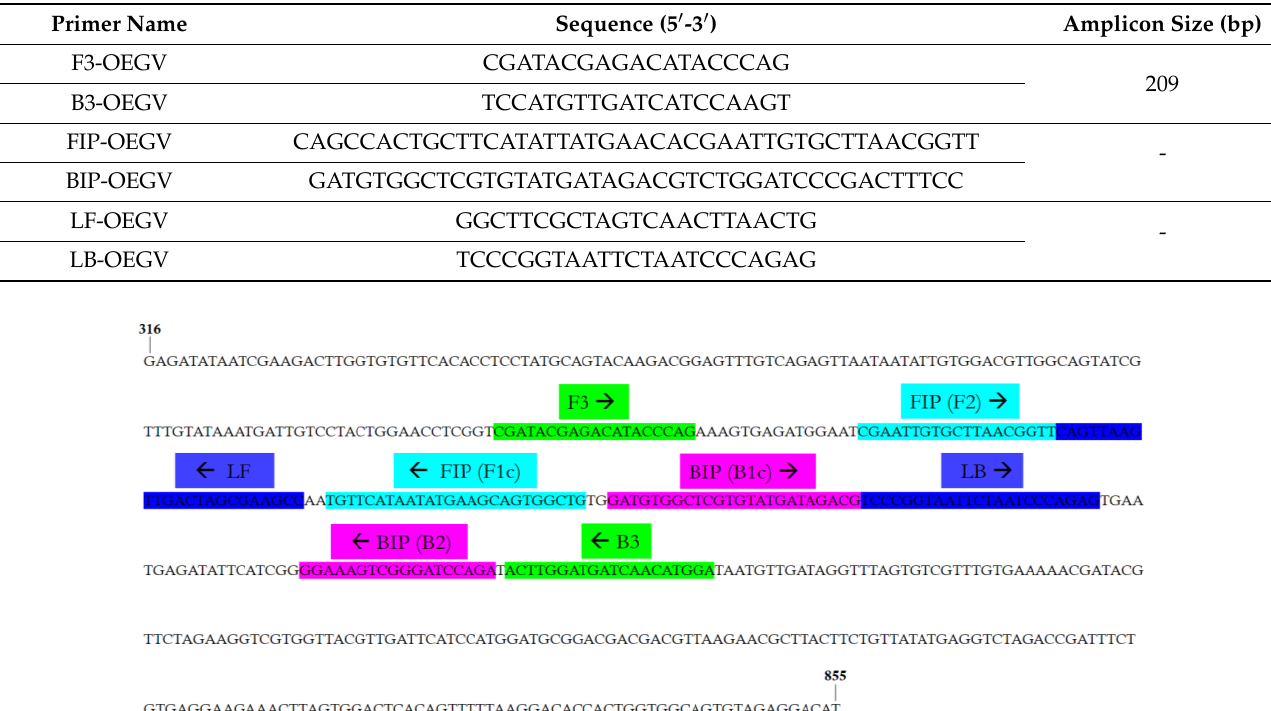
Table 2. Primers used for OEGV detection by LAMP.